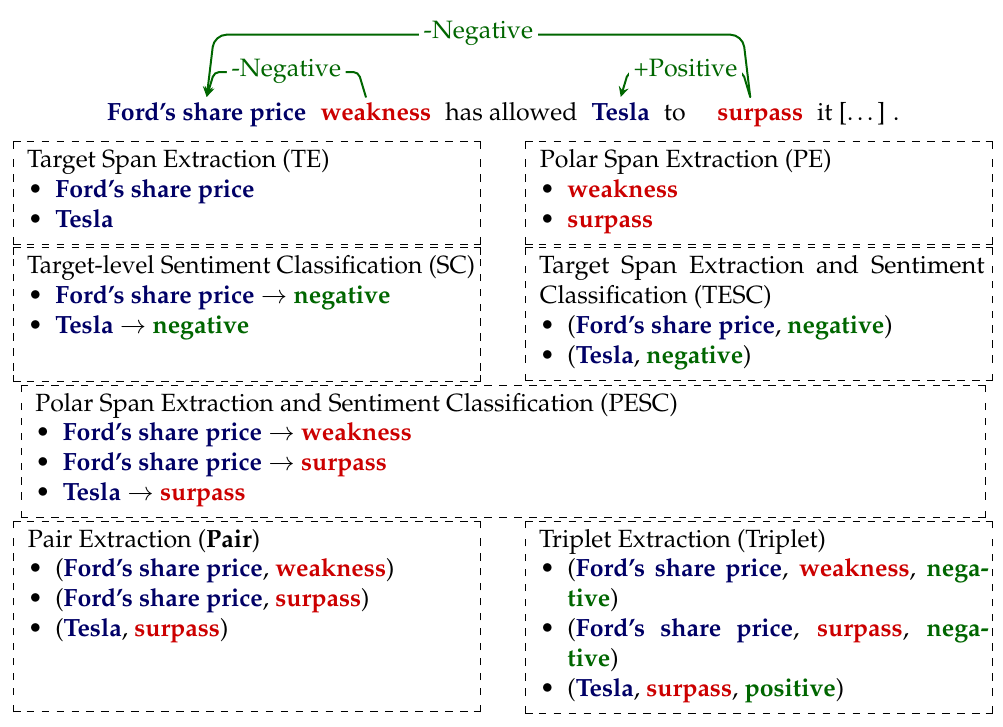
Figure 1. Overview of fine-grained target-based sentiment analysis subtasks enabled by the SEN- TiVENT dataset. Overview recreated from Mao et al. [50] but terminology adapted to implicit polar